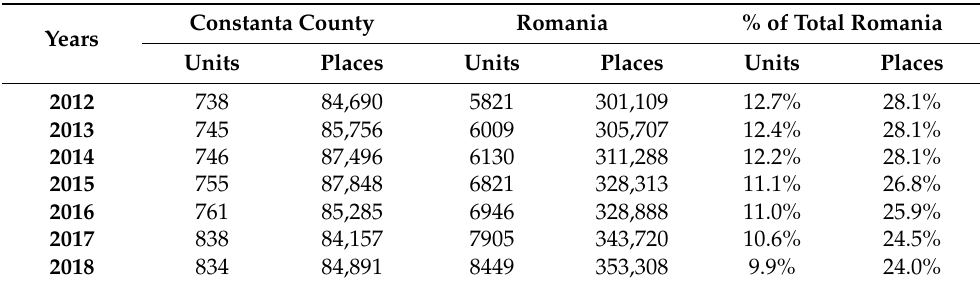
Table 2. Evolution of accommodation capacity at the level of Constanta County and for the total country. Source: TEMPO-Online database (http://statistici.insse.ro:8077/tempo-online/#/pages/ tables/insse-table) accessed on 10 June 2021.